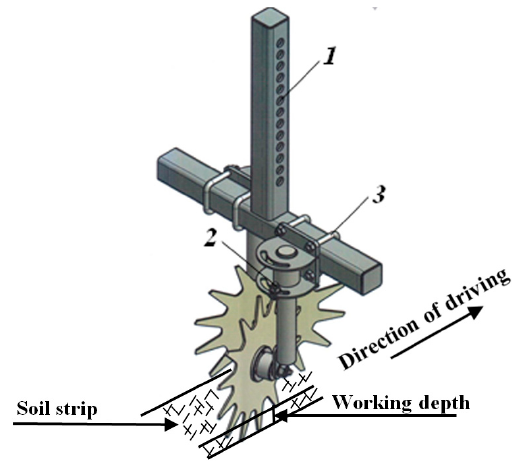
Figure 2. Serrated disc row cleaner: 1—Adjustment of working depth; 2—adjustment of slip angle; 3—adjustment of gap between discs.